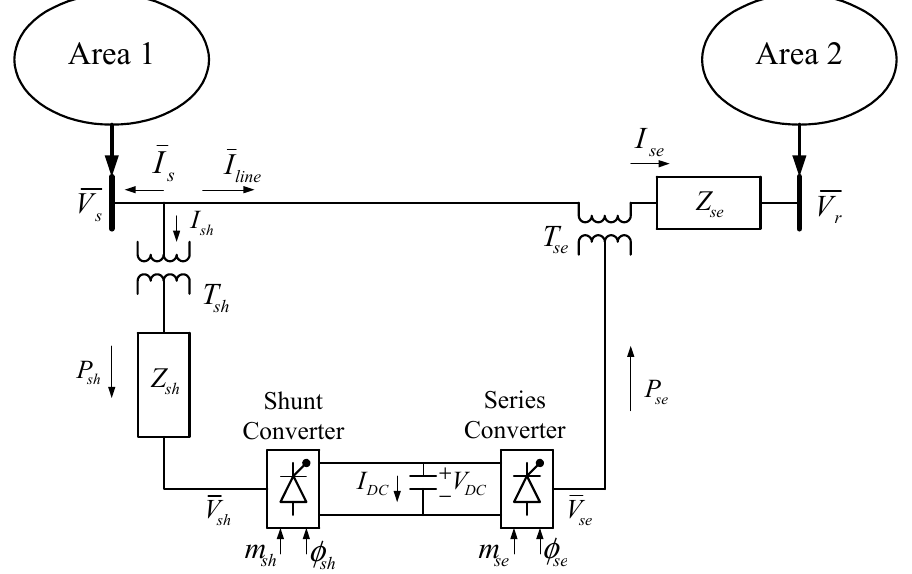
Figure 5. Single line diagram of two-area power system with unified power flow controller (UPFC). Table 1. Parameters of Fuzzy PID controller. SSSC—static synchronous series compensator;